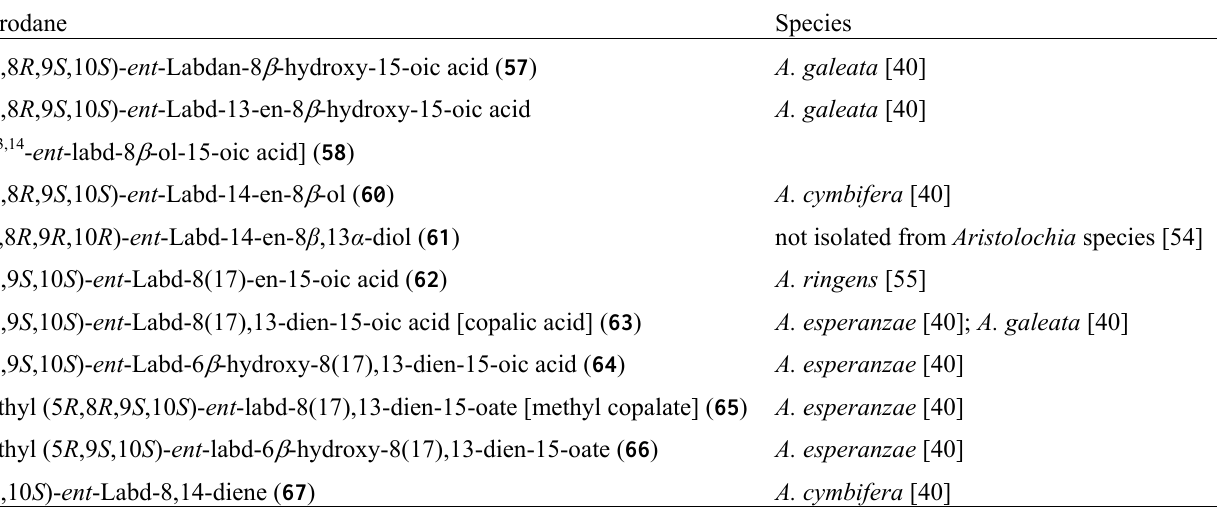
Table 3. Labdane diterpenoids isolated from Aristolochia